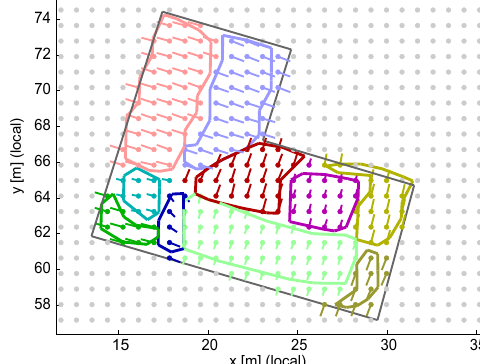
(b) Points q and normal vectors m of the local surface planes, plotted over the segment boundaries. Colours correspond to the segment labels l SP .